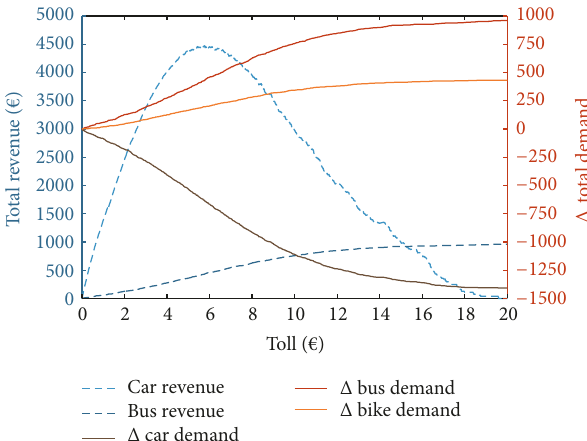
Figure 11: Revenue for one day of operation of the pricing strategy in the city of Molfetta and variation of the modal split, in relation to the amount of the toll.